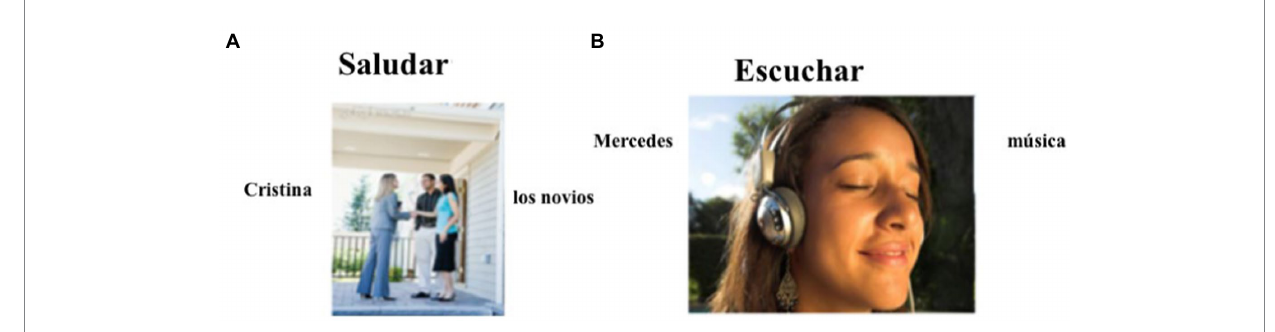
FIGURE 2 Sample of items used in the oral elicitation task: (A) shows the picture used for the verb saludar ‘to greet’; (B) shows the picture used for the verb escuchar ‘to listen’ [reproduced with permission from Arechabaleta-Regulez and Montrul